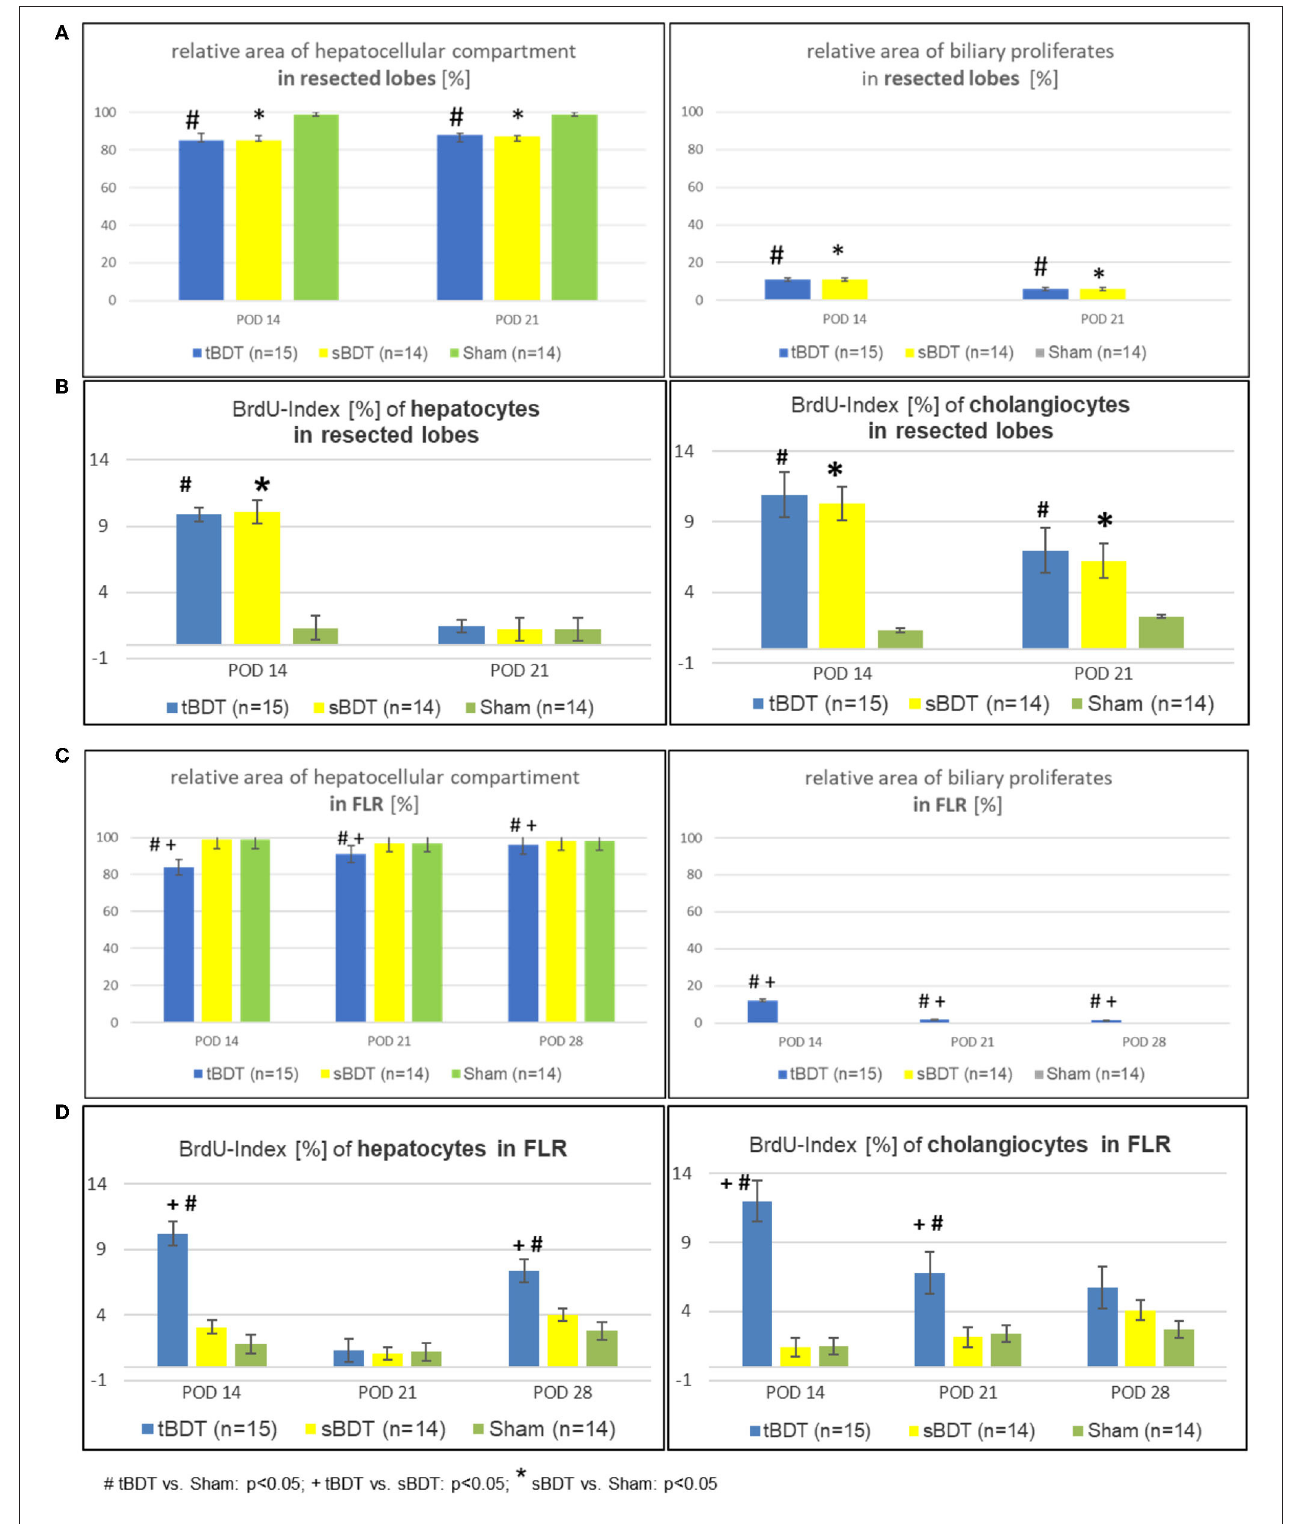
FIGURE 3 | (A–D) Morphological alterations of the liver architecture focussing on the main cell compartments (e.g., hepatocytes and cholangiocytes) and their related proliferative activities during the sequence of “repeated regeneration stimuli” in (A,B) “resected lobes” and (C,D) the FLR during the sequence of “repeated regeneration stimuli” in different extents of biliary occlusion (tBDT 100%, sBDT 70%, Sham 0%) in rats ( n = 45). The sequence consisted of two different regeneration stimuli: selective portal vein ligation at POD 14 (sPVL) followed by an extended liver resection at POD 21 (70%PHx) after induction of occlusive cholestasis of different extent (tBDT 100%, sBDT 70% or Sham with 0%; # tBDT vs. Sham: p < 0.05; + tBDT vs. sBDT: p < 0.05; * sBDT vs. Sham: p < 0.05).